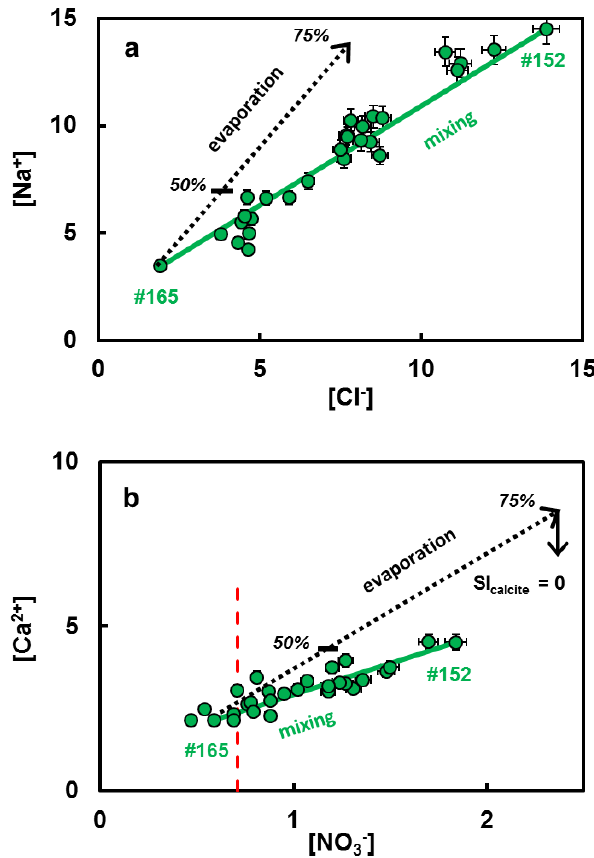
Figure 3. Chemical composition of groundwater from Hasouna, Libya. (a) Na + vs. Cl − concentration. (b) Ca 2 + vs. NO − tration. Values are given in mM.Solid green lines: mixing between end-member solutions #165 and #152 with the lowest and highest ion concentrations, respectively. Dotted arrows: chemical trend for evaporation of solution #165, where 50 and 75% denote ion con- centrations at the respective loss of H 2 O by evaporation. Solid ar- row: Decrease in Ca 2 + concentration by considering calcite pre- cipitation to reach SI calcite = 0. Dashed red line: MCL for NO − drinking water according to the WHO (WHO, 2004).